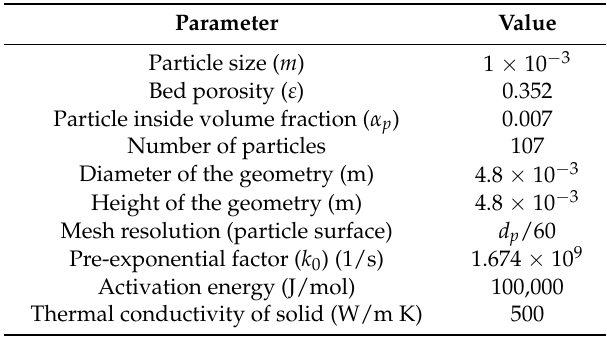
Table 1. Packed bed geometry and flow simulation properties.